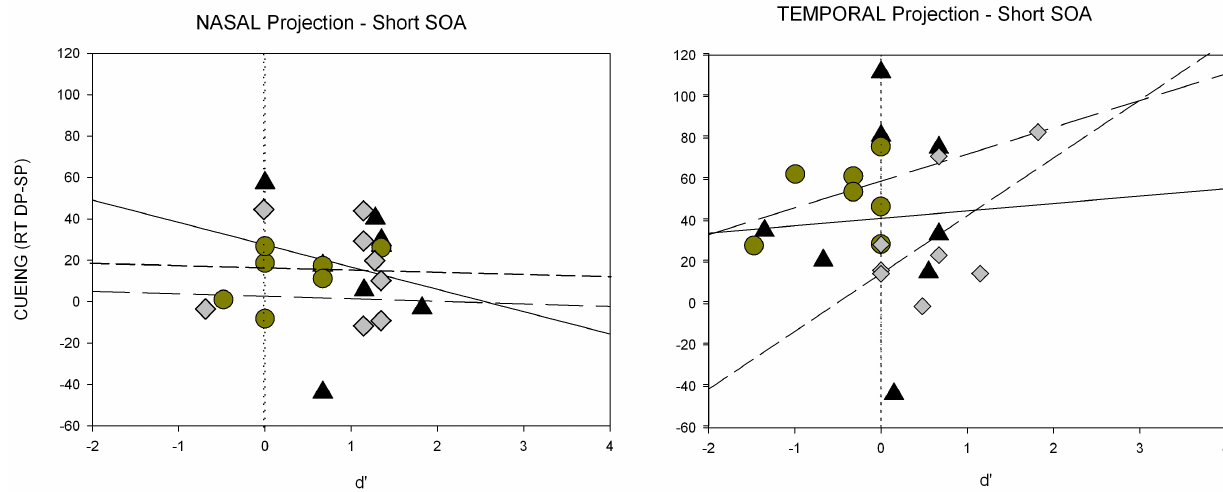
Figure A3. Individual scatter plots of the short SOA for Experiment 3. Shown are RT differences (cueing effects, i.e. , mean RTs for DP minus RTs for SP condition on the y -axis) and the respective d’ -value (on the x -axis) for each participant separately. Panels depict results separately for nasal (left side) and temporal hemifield projection (right side). Within each panel, values for all three cue conditions are shown: same polarity cues (triangles; solid regression line), opposite polarity cues (diamonds; short dashed regression line) and Mulckhuyse condition (circles; long dashed regression line).